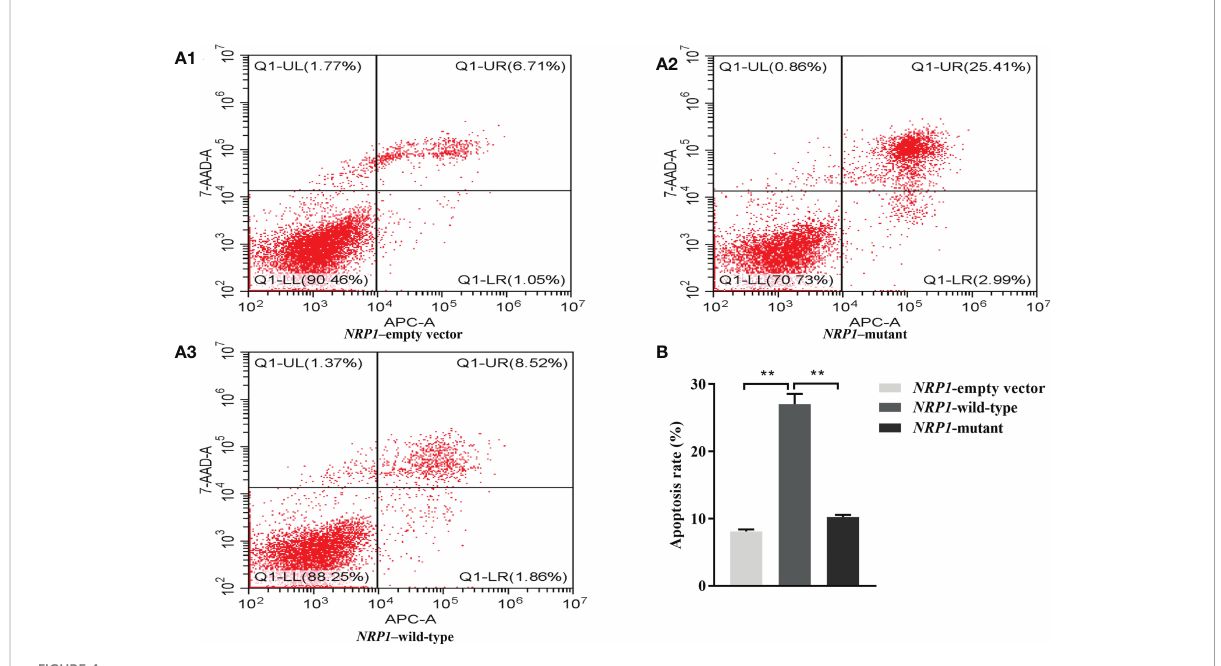
FIGURE 4 Cellular apoptosis comparisons among osteoclasts transfected with empty, and wild-type and mutant of NRP1 rs180868035 vectors. (A) fl ow cytometry. Representative APC-A-area versus 7-AAD-A-area density plots of different treatment groups with percentages of cells at different stage of apoptosis shown in the relevant quadrants. Q1-UR quadrant is positive for both APC-A and 7-AAD-A and represents cells in late apoptosis; Q1-LR is APC-A positive/7-AAD-A negative and represents cells in early apoptosis; Q1-LL is negative for both APC-A and 7-AAD-A and contains viable cells; Q1-UL is 7-AAD-A positive/APC-A negative and contains cells undergoing necrosis. (B) histogram of osteoclast apoptosis. ** indicated P <